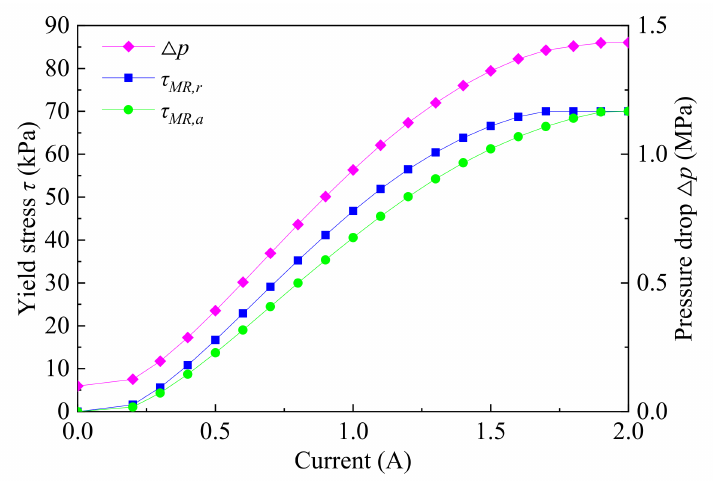
Figure 8. Variation curve of the shear stress and total pressure drop with the applied